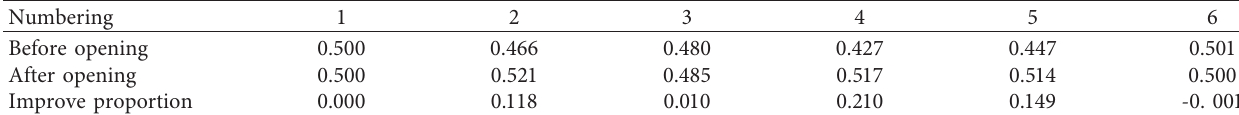
Table 4: Comprehensive evaluation of traffic capacity of surrounding roads before and after the opening of Songbai community in Xiamen